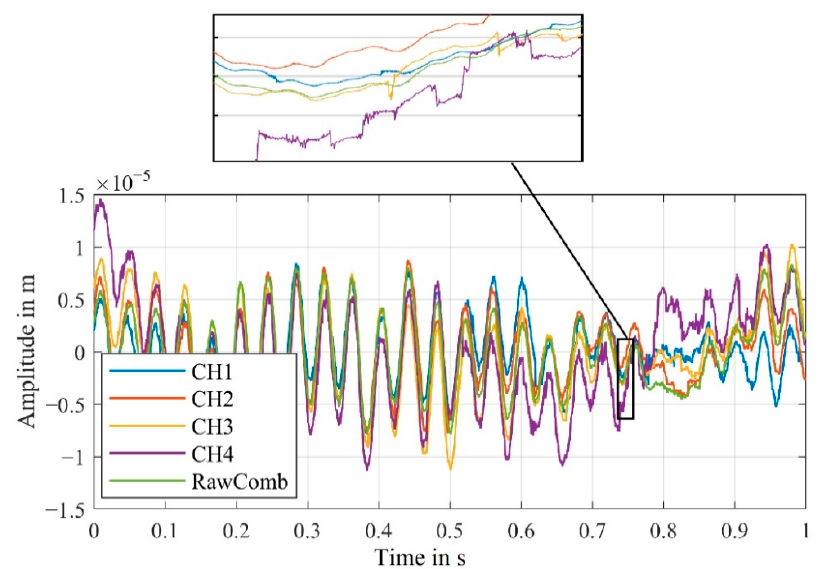
Figure 15. Comparison of the demodulated displacement signals of the four channels CH1–CH4 and the combined signal; (RBW = 1 Hz).